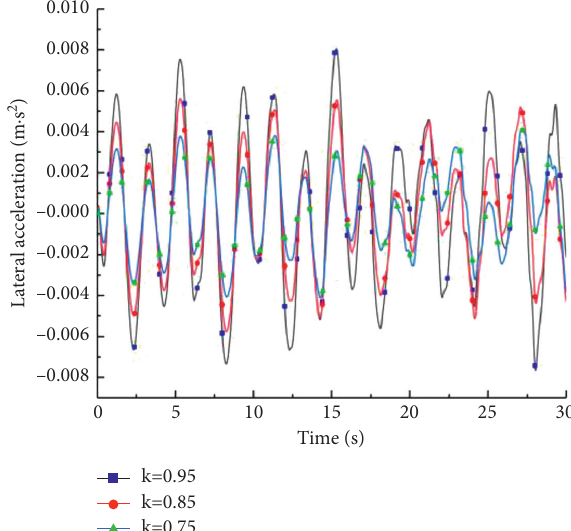
Figure 16: Lateral acceleration curves of the high-clearance